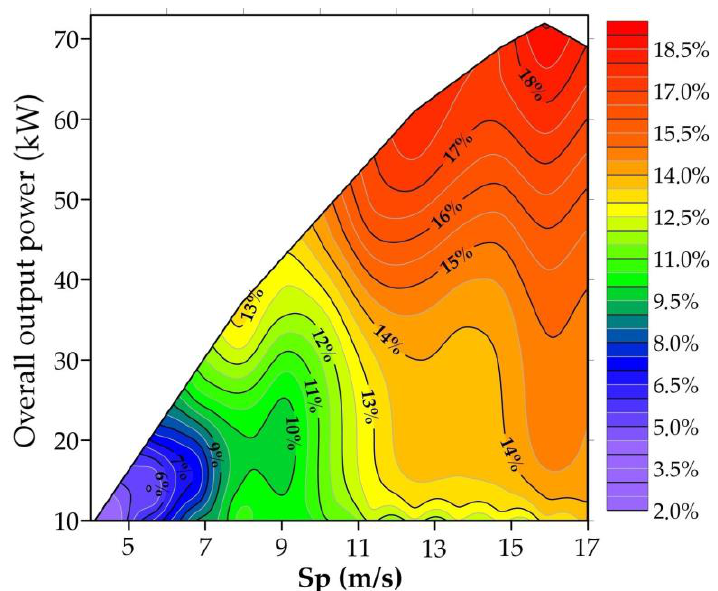
Figure 15. Efficiency improvement of the realistic compound engine compared to the reference turbocharged engine, as a function of power output and mean piston speed.